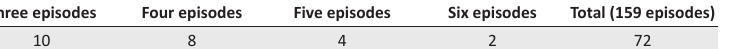
TABLE 2: The number of episodes per